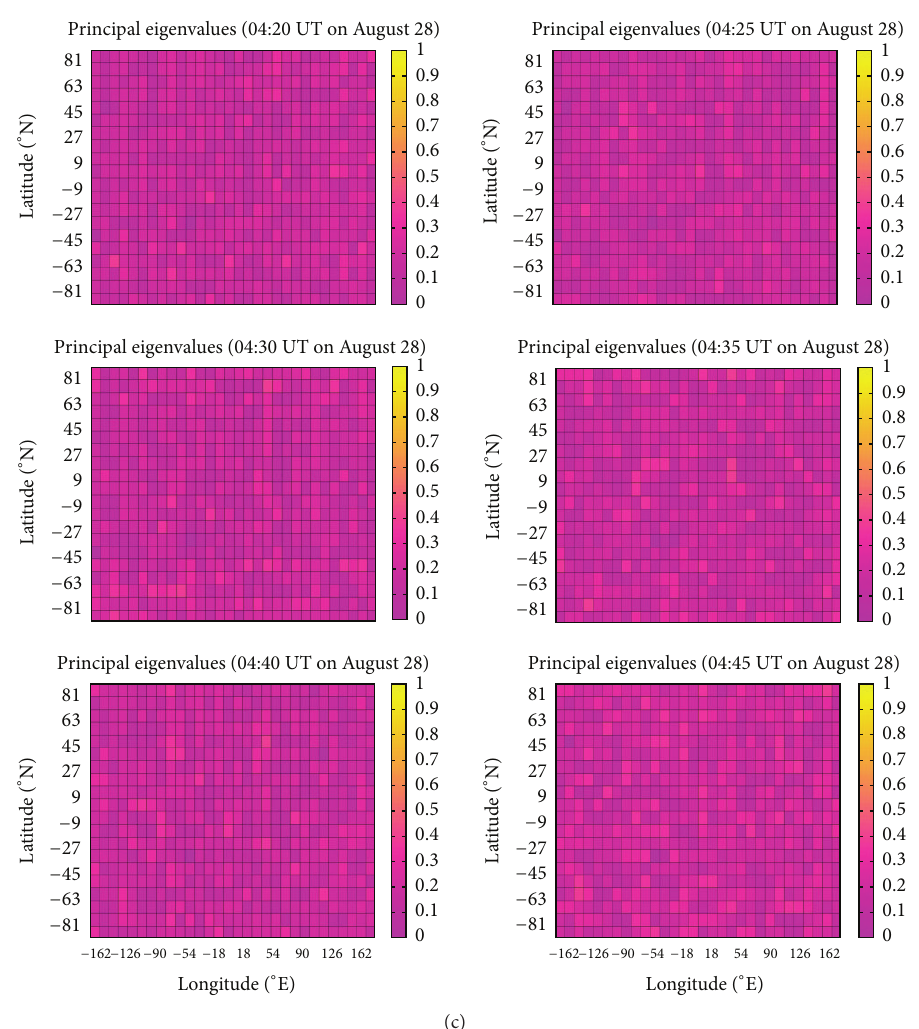
Figure 1: (a) The figures show the GIMs during the time period from 04:20 to 04:45 on 28 August 2012 (UT). (b) The figures give a color- coded scale of the magnitudes of principal eigenvalues of 2DPCA corresponding to Figure 1(a). The color within a grid denotes the magnitude of a principal eigenvalue corresponding to Figure 1(a), so that there are 600 principal eigenvalues assigned for 600 grids in each small map, respectively. (c) The figures give a color-coded scale of the magnitudes of principal eigenvalues of PCA corresponding to Figure